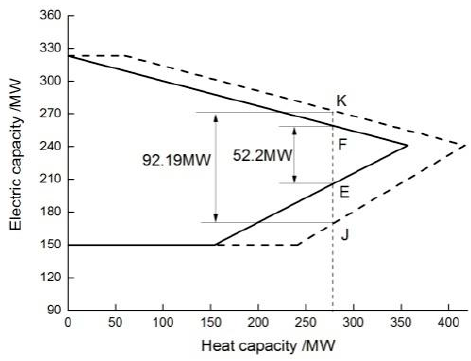
Figure 7. Peak shaving capacity with MPCMS storage system.